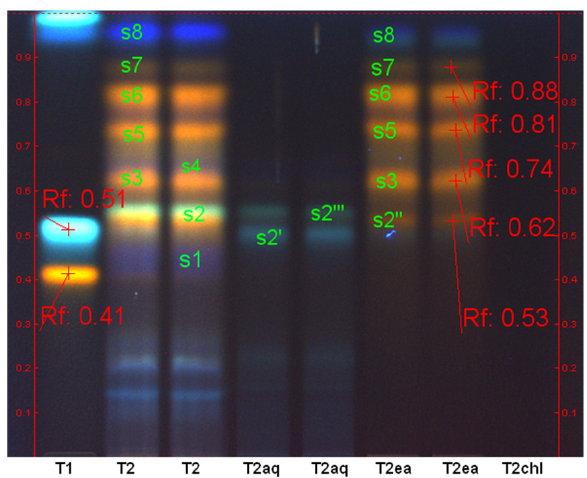
Figure 1: Qualitative (HPTLC) analytical aspects of Epilobi hirsuti herba whole and selective extracts. Track T1, rutin, chlorogenic acid and caffeic acid (ref.); Tracks T2, great willowherb whole extract (duplicate); Tracks T2aq, selective aqueous extract (duplicate); Tracks T2ea, selective ethyl acetate extract (duplicate); Track T2chl, selective chloroform extract (single